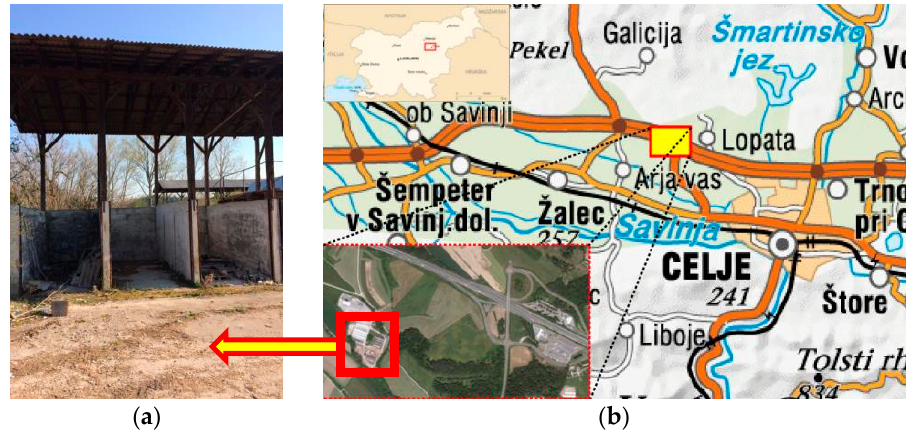
Figure 1. ( a ) An abandoned storage area was reused for the testing pool (left: pool 1; middle: pool 2; right: pool 3); ( b ) The location of the warehouse in Zalog near Celje (Slovenia) is marked on the map.